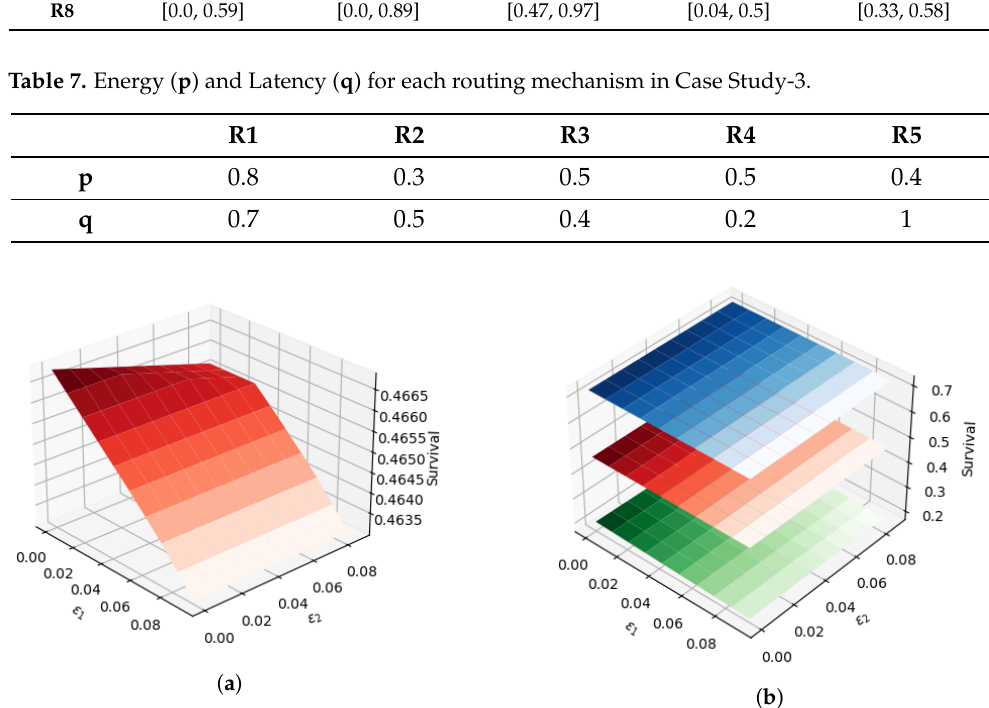
Figure 2. Case Study-3, Pareto surfaces. ( a ) Formulation (12a–f) Pareto. ( b ) Formulations (12a–f)– (14a–f) Pareto surfaces. Table 8. Minimax game values for Case Study-3 (at ε 1 = ε 2 =